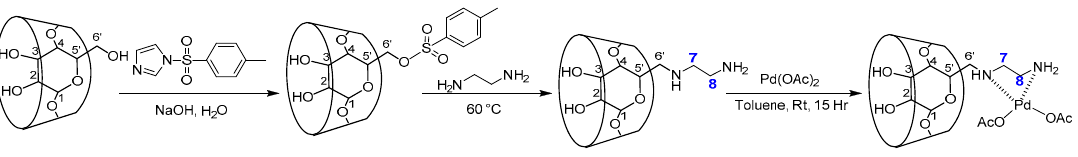
Scheme 1. Synthesis of the PdLn@Et- β -CD catalyst.